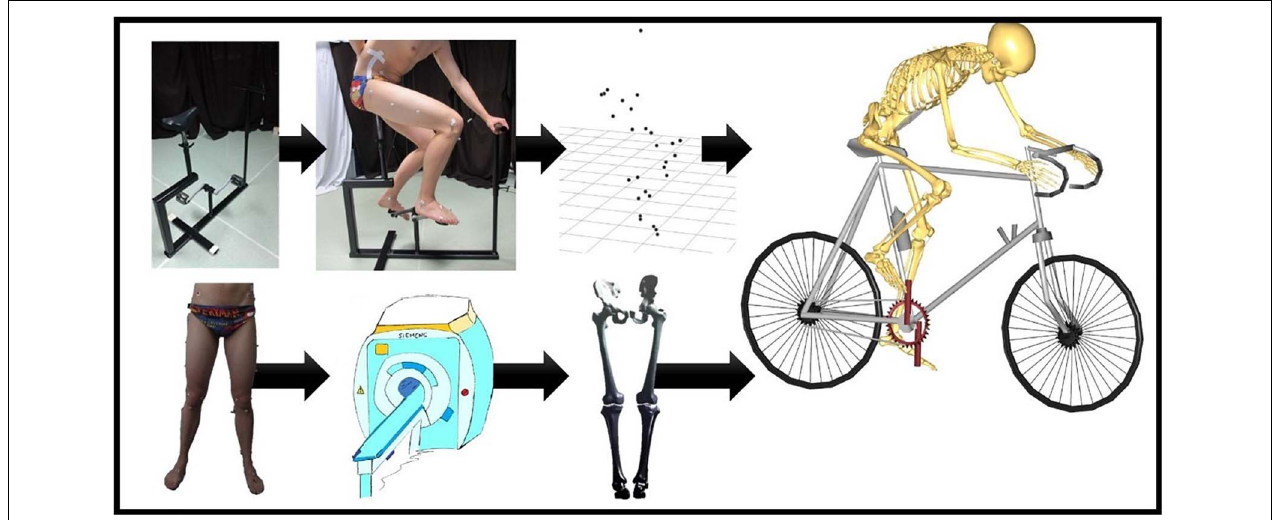
FIGURE 1 | Flow chart of the musculoskeletal simulation in the Anybody Modeling System. On the upper left, there is the bike model that was used by our test panel during the cycling experiments. Motion was recorded frame by frame through skin marker registration. Each subject underwent MRI for determination of the skin tags. Subsequently, Anybody calculated the kinematics for all the recorded frames. An identical workflow was applied for the simulation of squat, lunge, and stair movements.